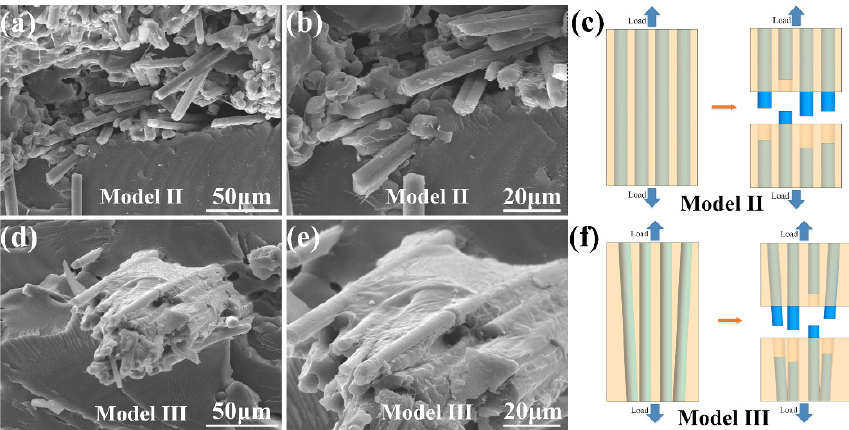
Figure 5. The microstructure of the tensile test sample of ( a ) and ( b ) Model II, ( c ) the schematic diagram of tensile fracture of Model II. The microstructure of the tensile test sample of ( d ) and ( e ) Model III, ( f ) the schematic diagram of tensile fracture of Model III.